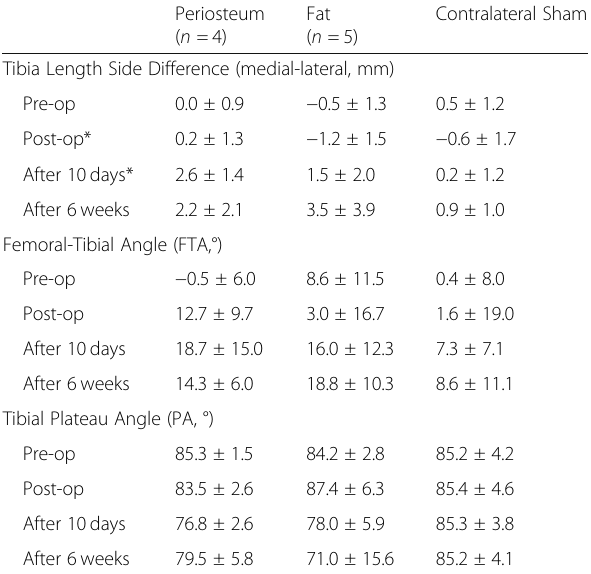
Table 1 Radiographic